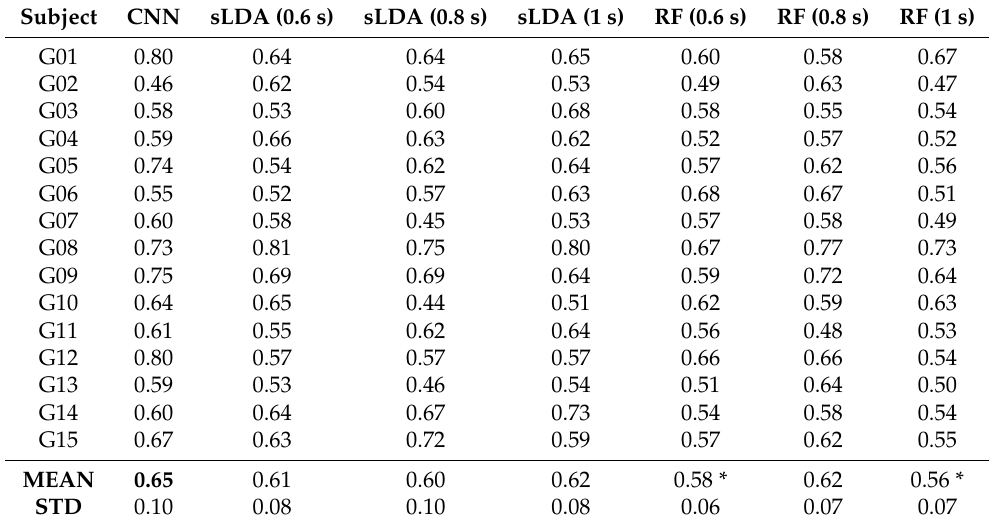
Table A4. Comparison of classification performance (in terms of recall) in validation from Dataset 2